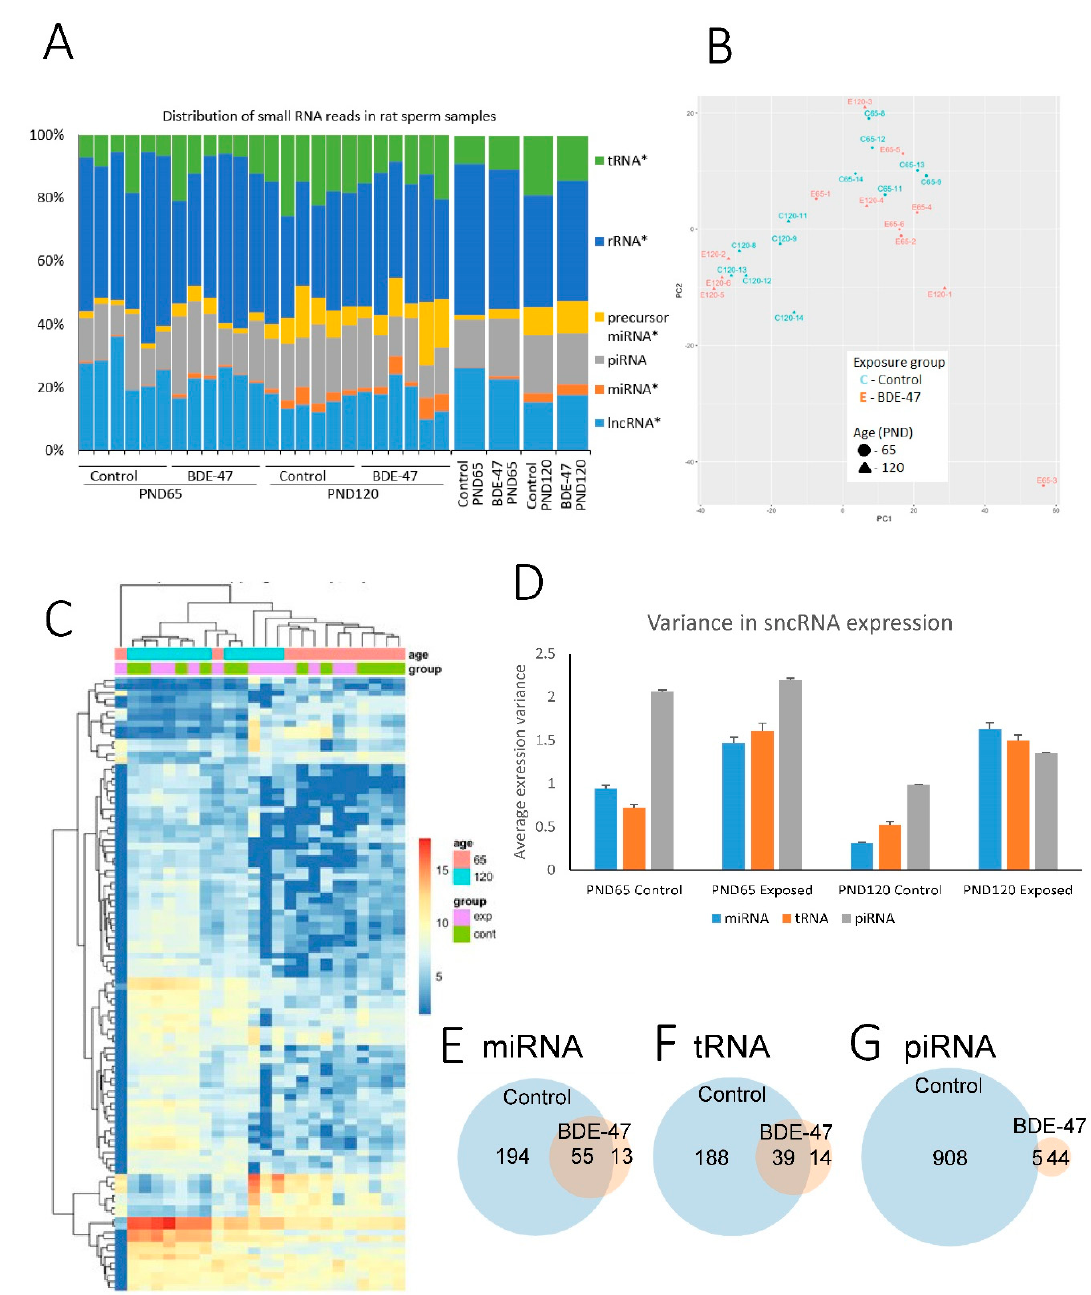
Figure 2. Age and BDE-47-dependent changes in profiles of sncRNA expression; ( A )—distribution of di ff erent types of RNA fractions across biological samples, ( B )—PCA plot of all biological samples based on miRNA expression, ( C )—expression heatmap and hierarchical clustering of biological samples based on expression of 100 miRNA with top highest standard deviations, ( D )—variance of sncRNA expression in age and exposure groups, ( E – G )—overlap of di ff erentially expressed miRNA ( E ), tRNA ( F ) and piRNA ( G ) in control and BDE-47-exposed animals. We hypothesized that the later observation may be at least partly due to the fact that exposure increases variance in expression levels across biological replicates; therefore, a smaller number of individual RNAs passes our threshold of FDR-adjusted p -value. To test this hypothesis, we compared the variance in expression values across age and exposure groups (Figure 2D). This comparison indeed shows that exposure increases the variance of non-coding RNA in both age groups. It is